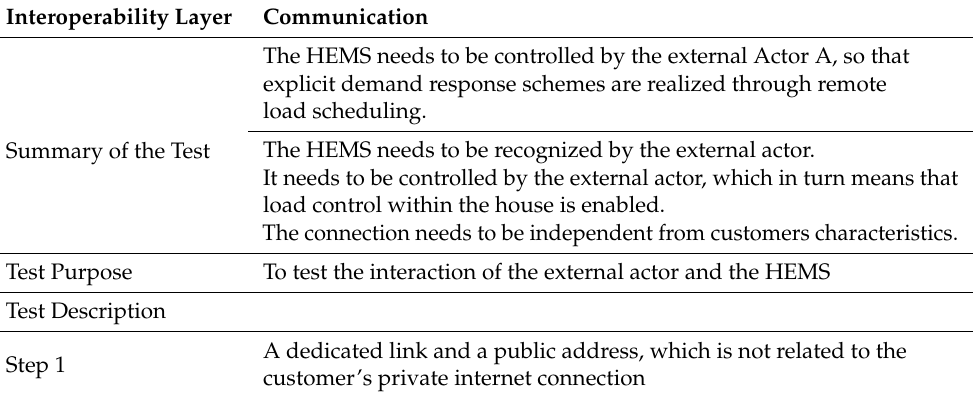
Table 2. BAIOP for the communication